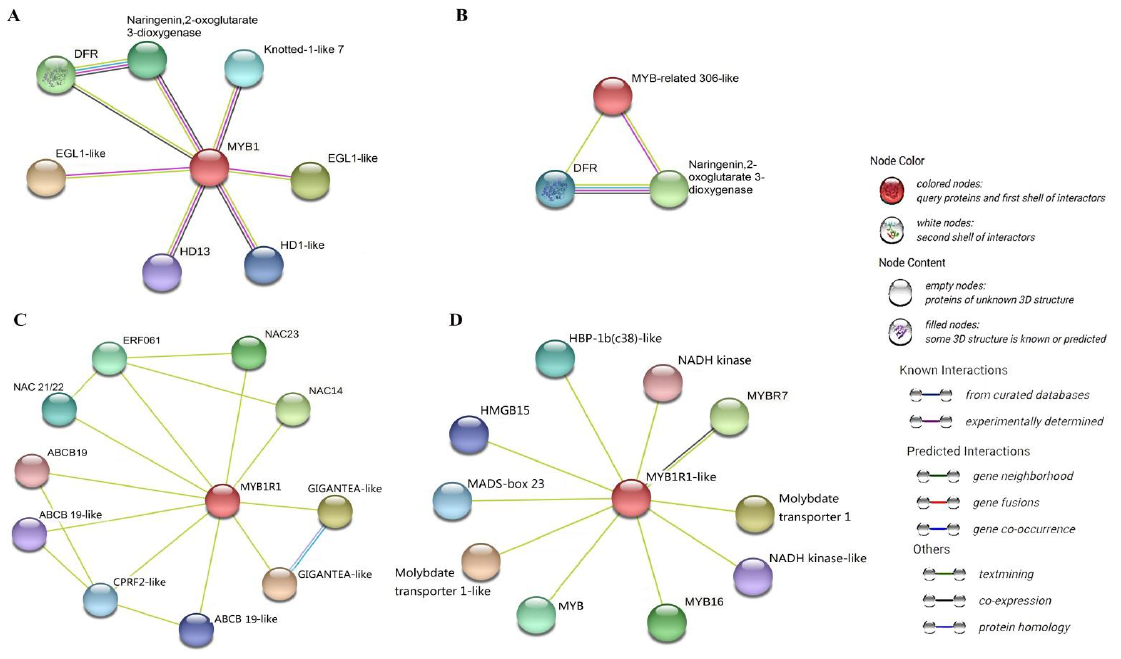
Figure 5. Interaction network analysis for key TFs. ( A – D ) Sequential representation of the interaction network of four TFs (MYB1, MYB-related 306-like, MYB1R1, MYB1R1-like). According to the prediction results, some TFs can interact with DFR, which is a struc- ture gene of anthocyanin biosynthesis. Moreover, we selected other structural genes, namely, DFR , CHS , CHI , and ANS . According to the interaction analysis, the transcription levels of these genes over the whole color transient period in high-altitude samples were